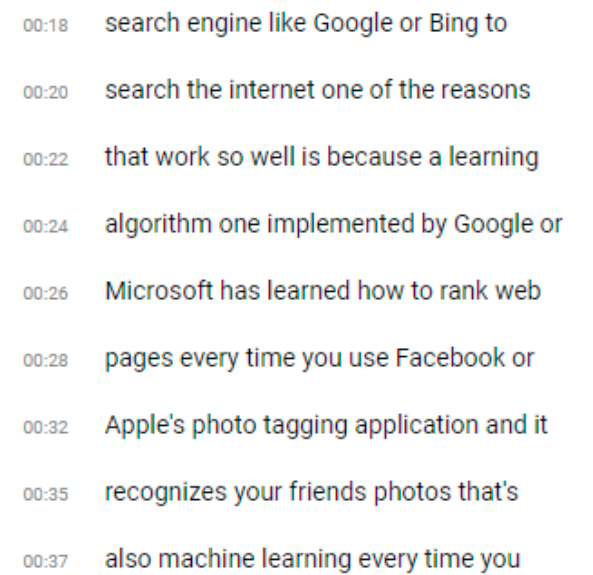
Figure 1. Examples of captions generated automatically in YouTube.